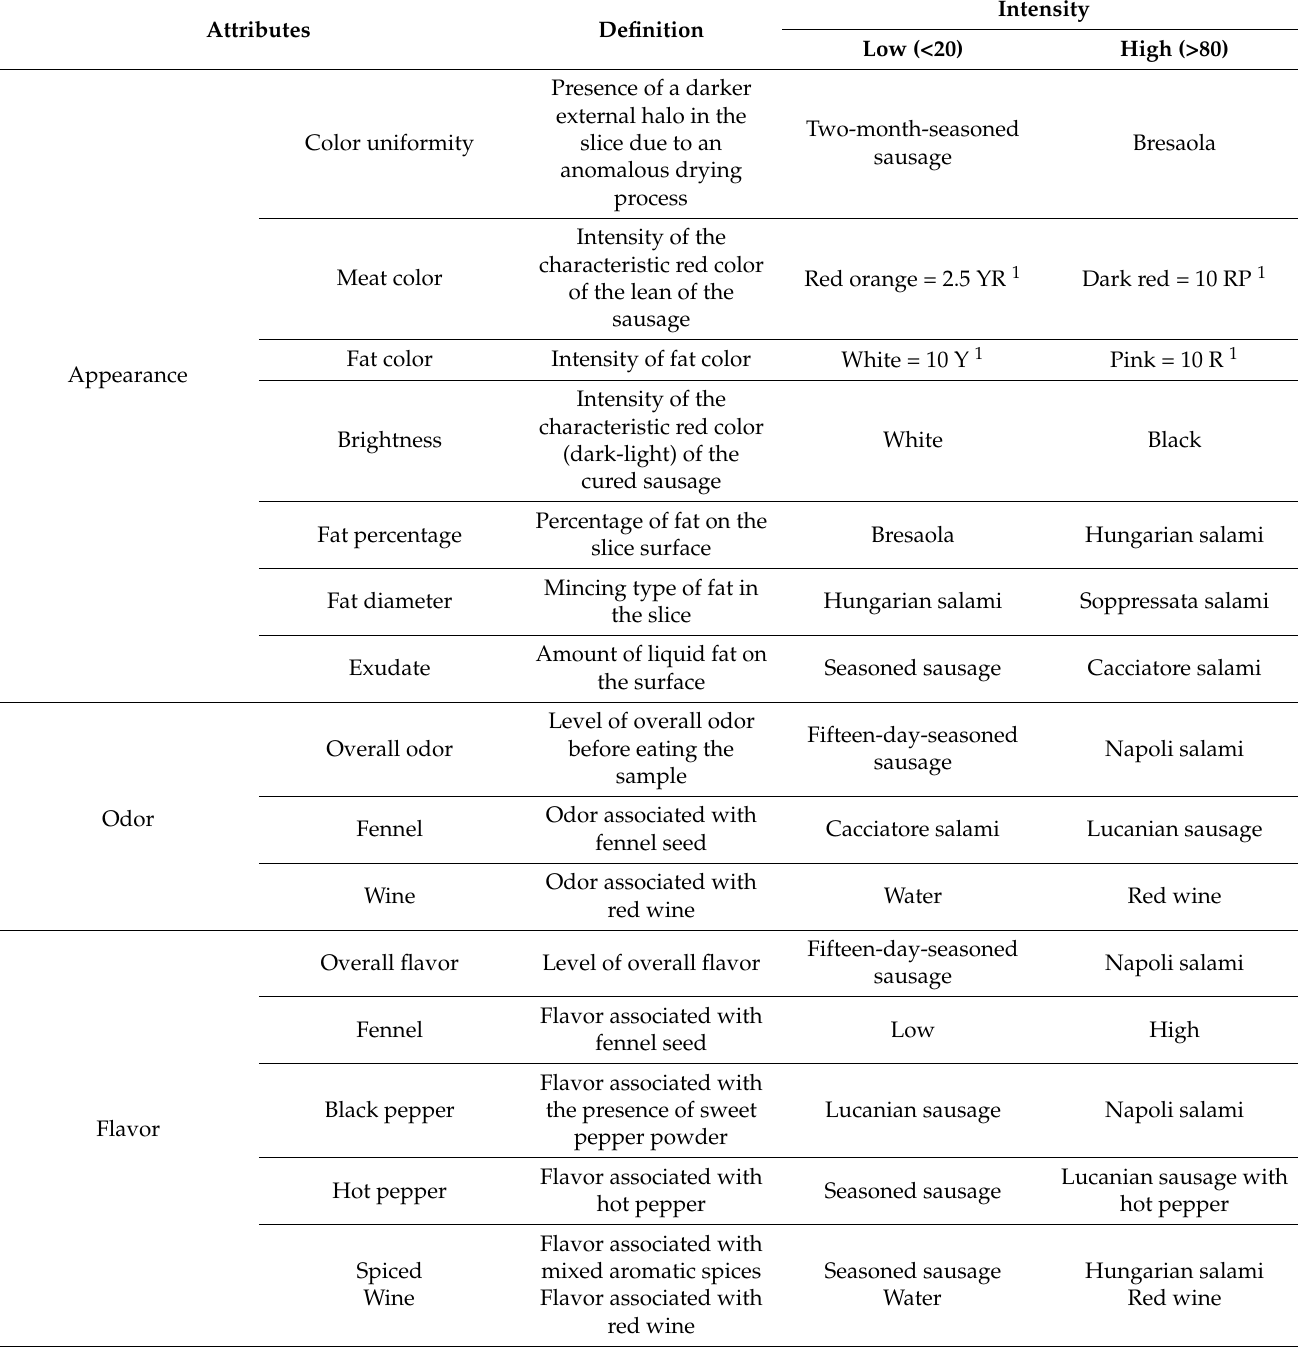
Table 2. List of attributes and reference frame used by 10-member panel for Cacciatore salami sensory